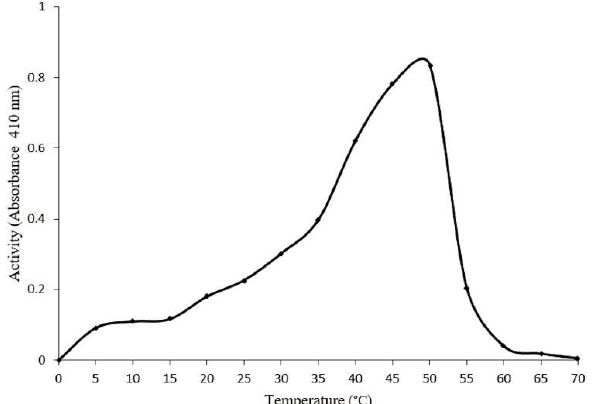
Figure 5. Effect of different pH(s) on the activity of the purified enzyme β -glucosidase in Sechium edule.